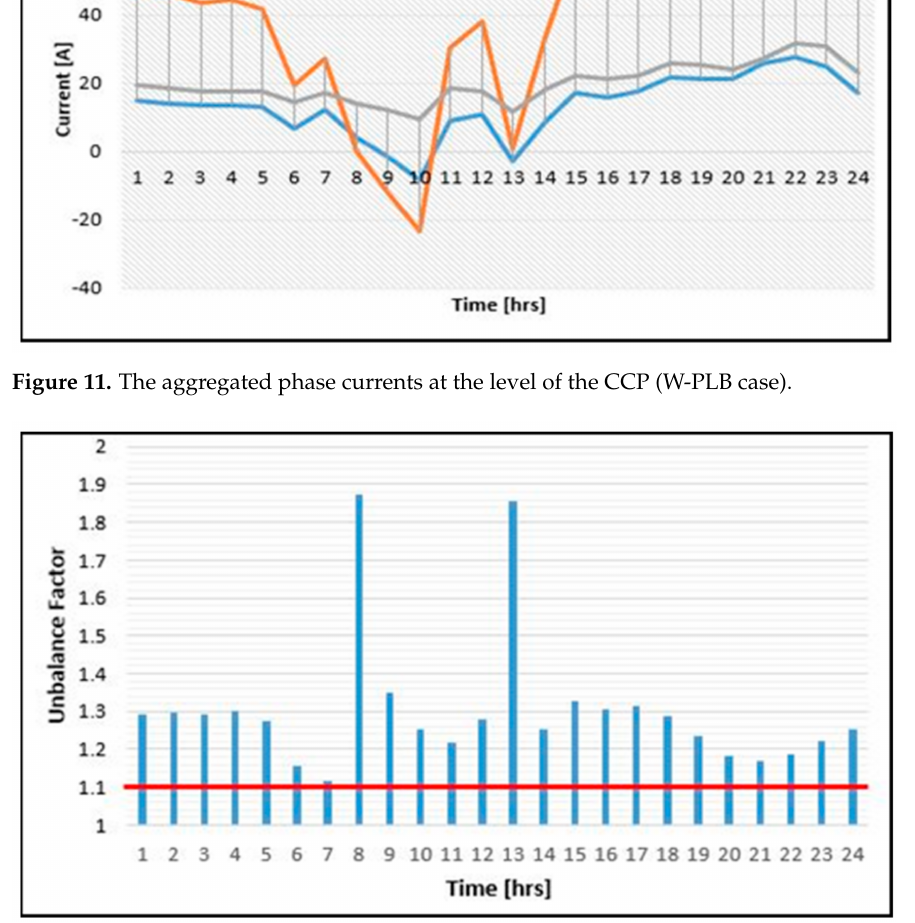
Figure 12. The hourly unbalance factor obtained at the CCP level (W-PLB